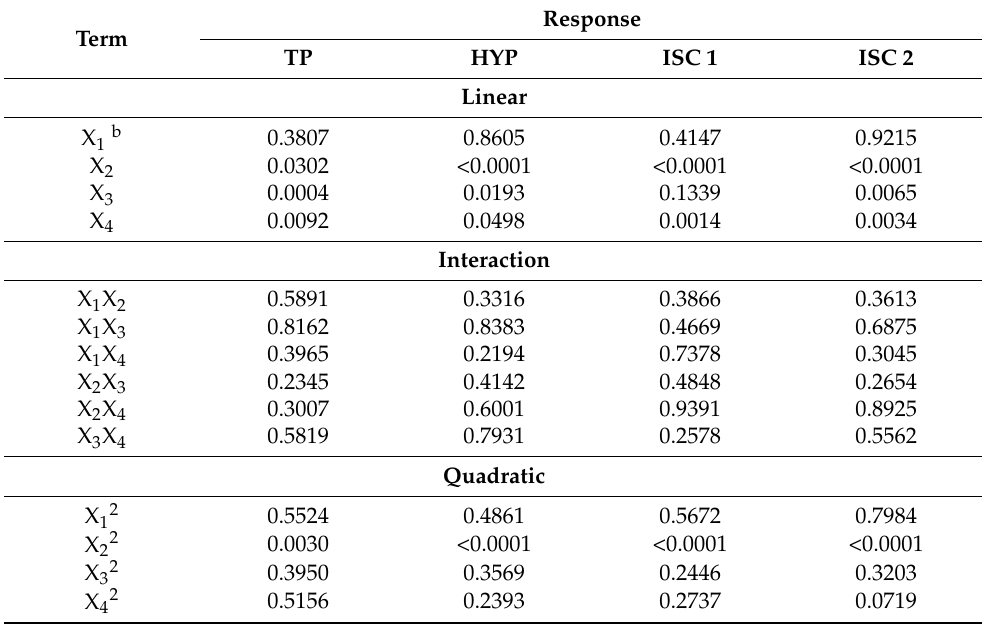
Table 3. Corresponding p -values of linear, interaction, and quadratic terms of regression coefficients obtained for selected response variables (TP, HYP, ISC 1, and ISC 2) a .